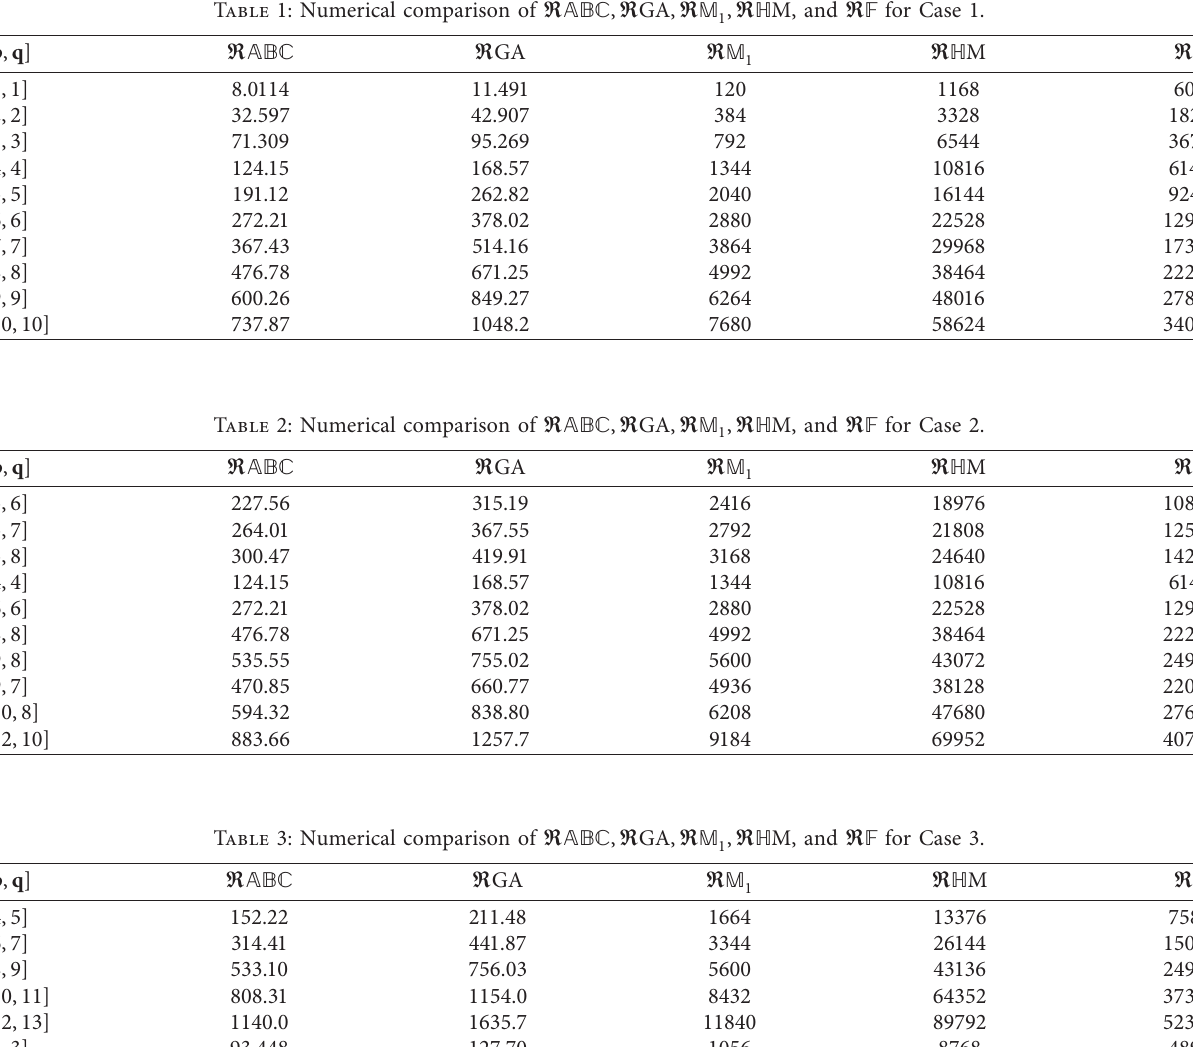
Table 1: Numerical comparison of R ABC , R GA , R M